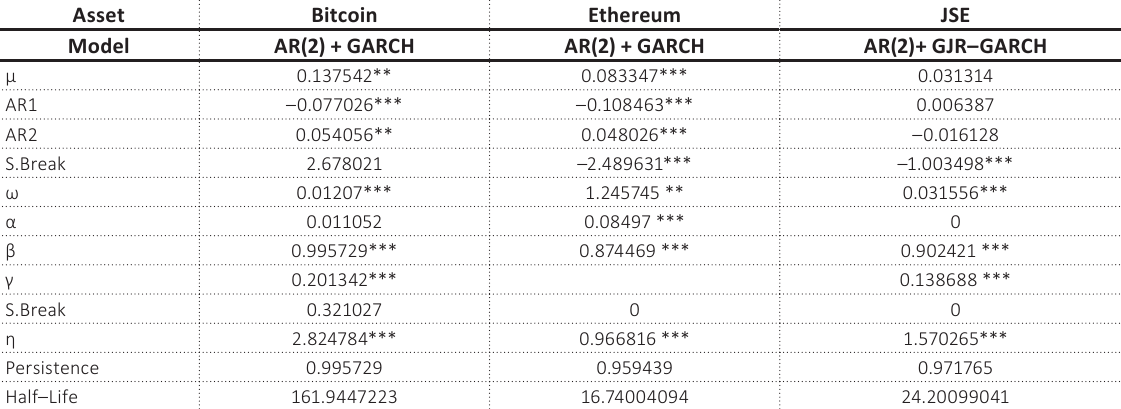
Table 6. Parameter estimates for models with structural breaks